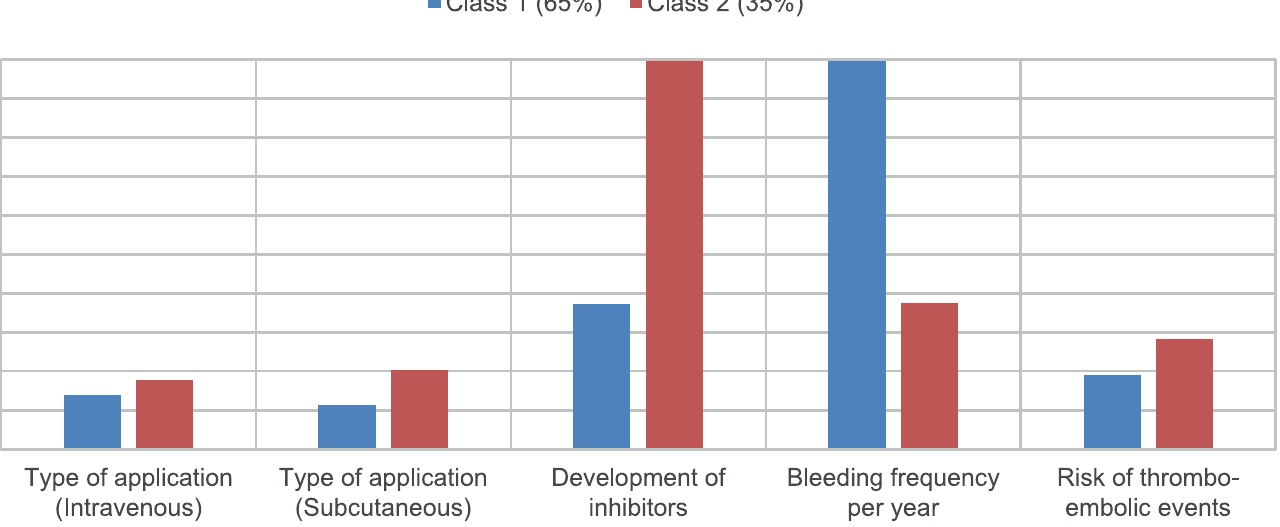
Fig 1. Relative attribute importance. The importance of each attribute is derived by the range between the lowest level coefficient and the highest level coefficient. This range is then normalized on a scale of 1 to 10, where 10 is the highest value and thus the most important or preferred attribute. Class 1 respondents mainly focused on bleeding frequency, while class 2 respondents paid more attention to “Development of inhibitors” in choice